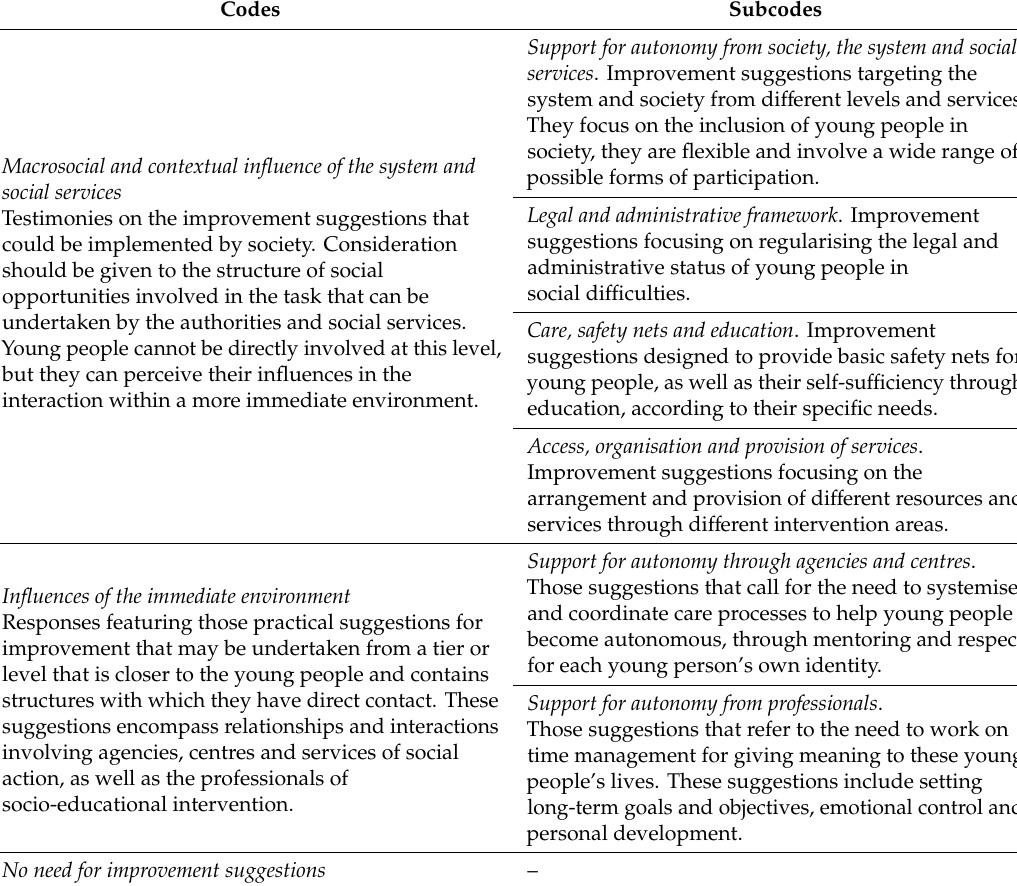
Table 1. Codes and subcodes arising from the data analysis.